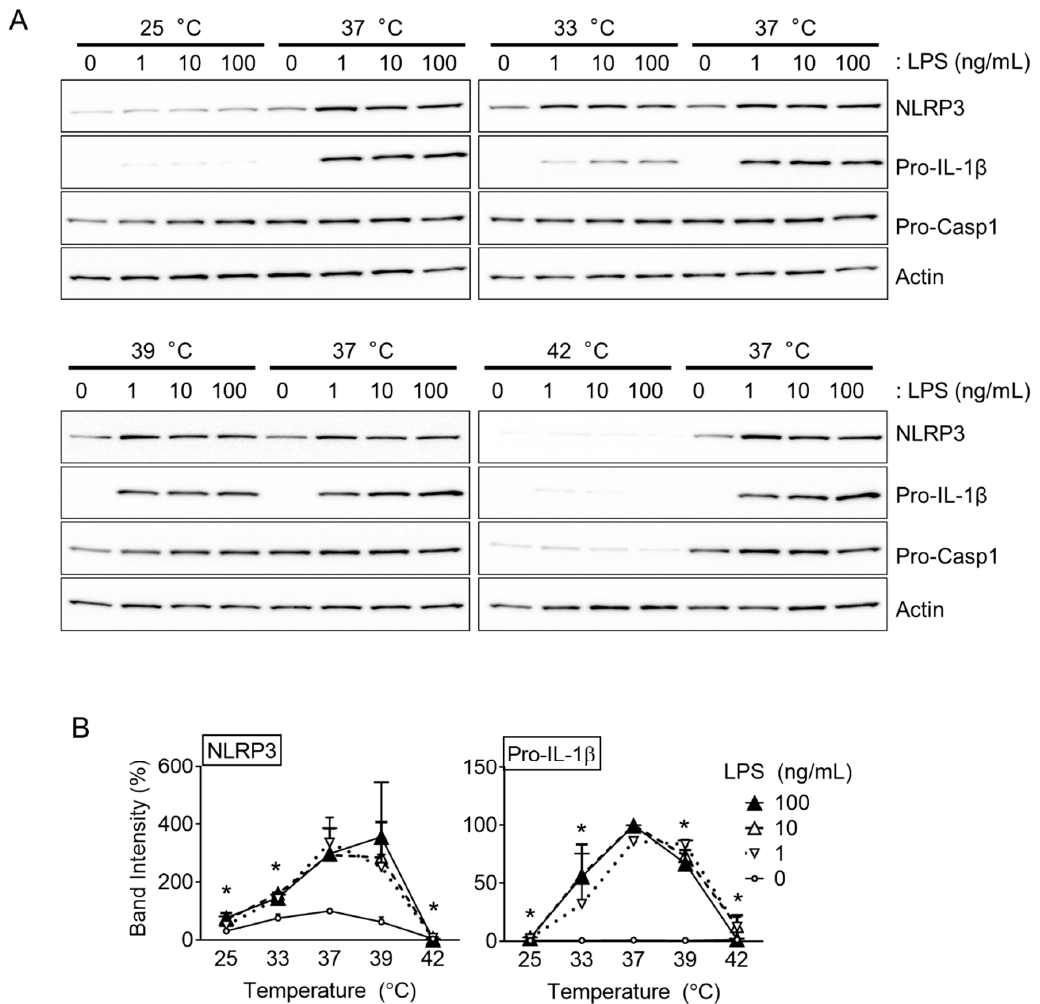
Figure 3. Effects of temperatures on the priming step. BMDMs were treated with increasing dosages of LPS (1, 10, and 100 ng/mL) for 3 h at 25, 33, 37, 39, or 42 °C. ( A ) The levels of NLRP3, pro-IL-1 β , and pro-Casp1 expression were determined by immunoblotting. ( B ) The band intensities of NLRP3 and pro-IL-1 β were analyzed. The bar graphs present the mean ± standard deviation (SD) of at least two independent experiments, and immunoblotting images are representative of two independent experiments. * p < 0.05 vs. 37 °C.